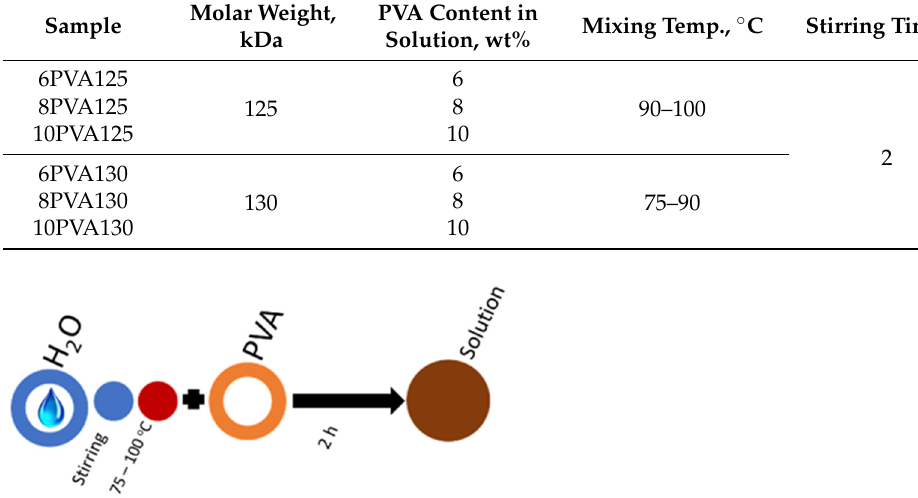
Figure 5. The mixing sequence required for PVA electrospinning solutions.